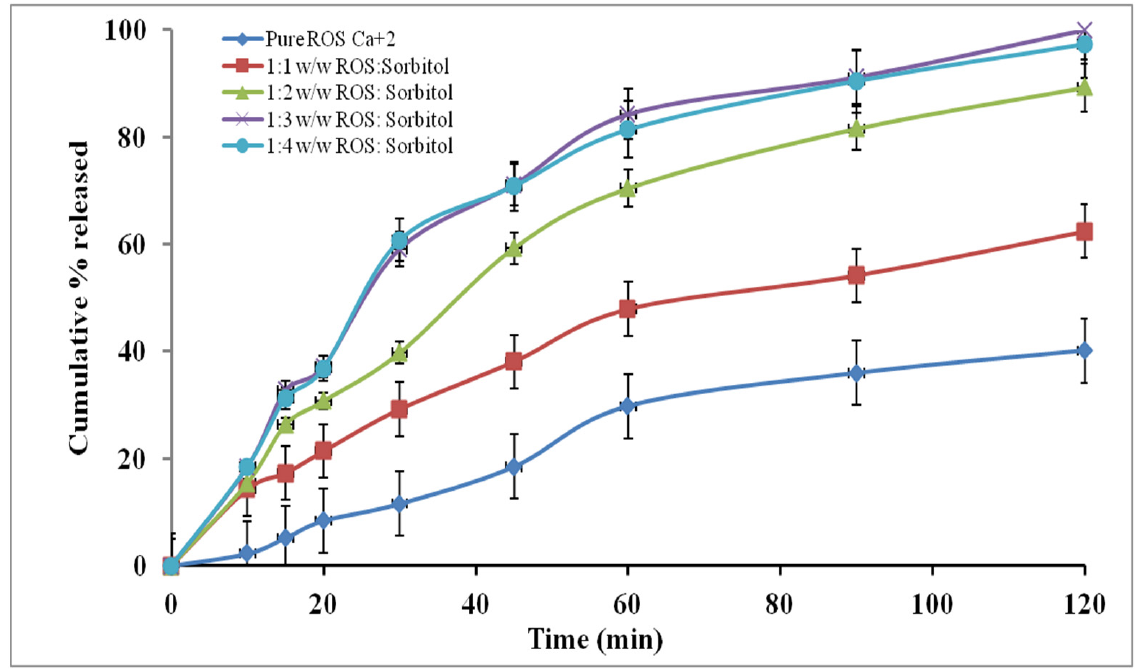
Figure 2. Dissolution profiles of pure ROS and ROS-SDs ( n = 3).